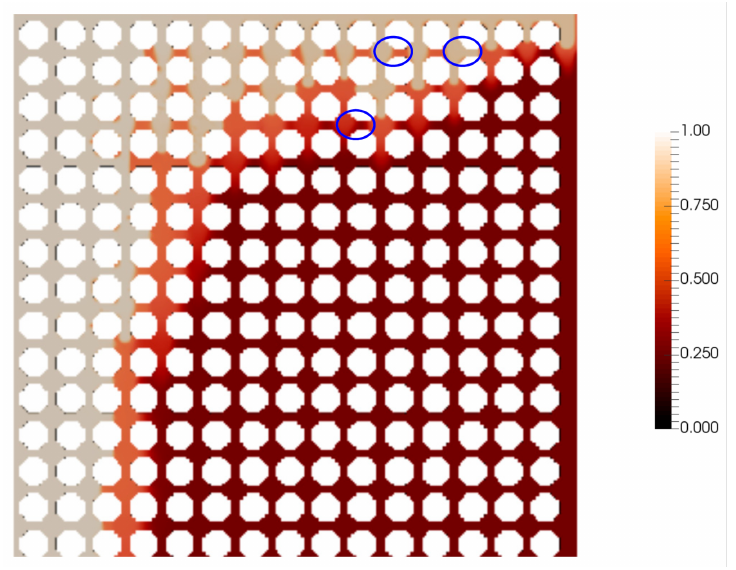
Figure 6. Butane fraction distribution in porous media. The blue oval shows the trapped oil in the throat. Solvent mole fraction differs in the range of 1.0 (grey) meaning pure solvent phase to 0.0 (maroon) meaning no solvent present in the